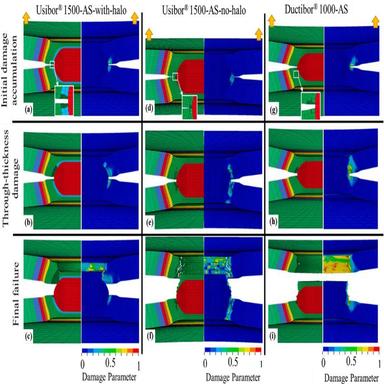
Failure simulation results for spot welds under normal load showing the location of failure and damage progression for (a), (b) and (c) Usibor® 1500-AS-with-halo, (d), (e) and (f) Usibor® 1500-AS-no-halo, and (g), (h) and (i) Ductibor® 1000-AS spot welds. Loading direction is shown by orange arrows. (For interpretation of the references to colour in this figure legend, the reader is referred to the web version of this article.)